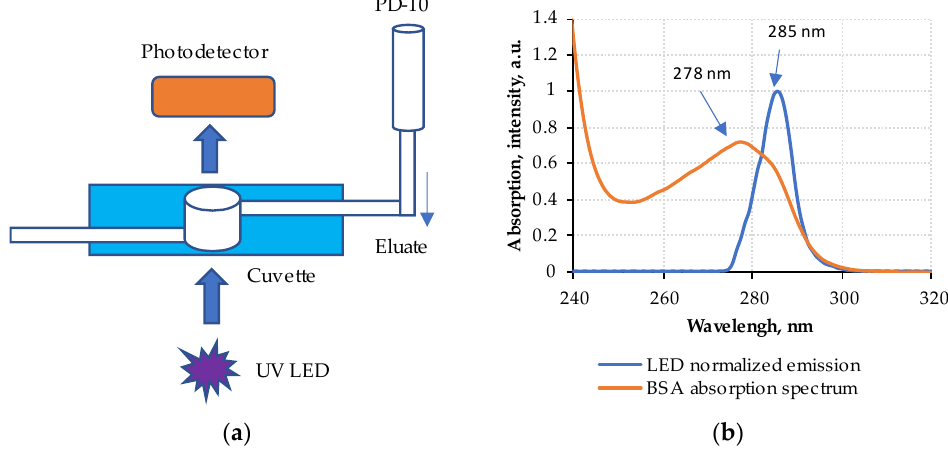
Figure 1. The general principle of the sensor operation: ( a ) Schematic diagram of the sensor; ( b ) BSA absorption and UV LED emission spectra.